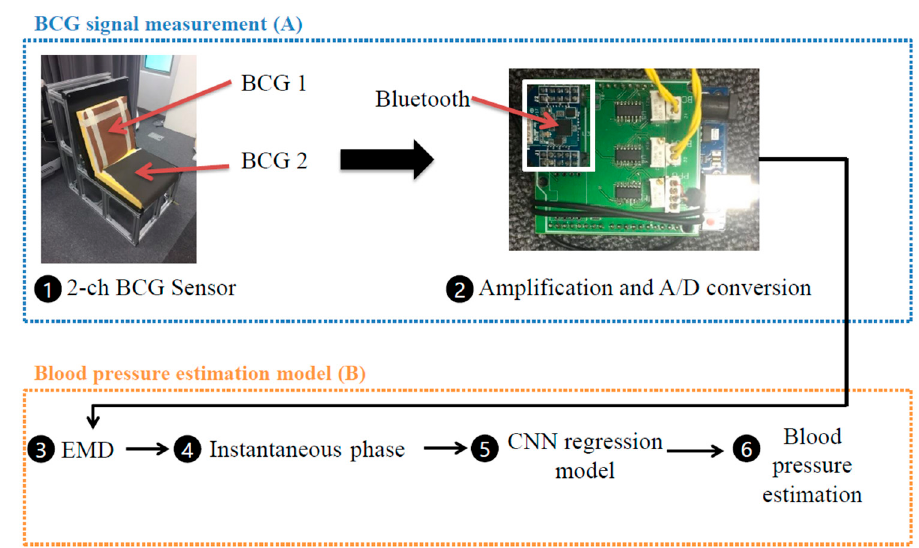
Figure 1. The overall workflow of the chair-shaped ballistocardiogram (BCG)-based blood pressure estimation system; ( A ) BCG signal measurement; ( B ) Blood pressure estimation model.